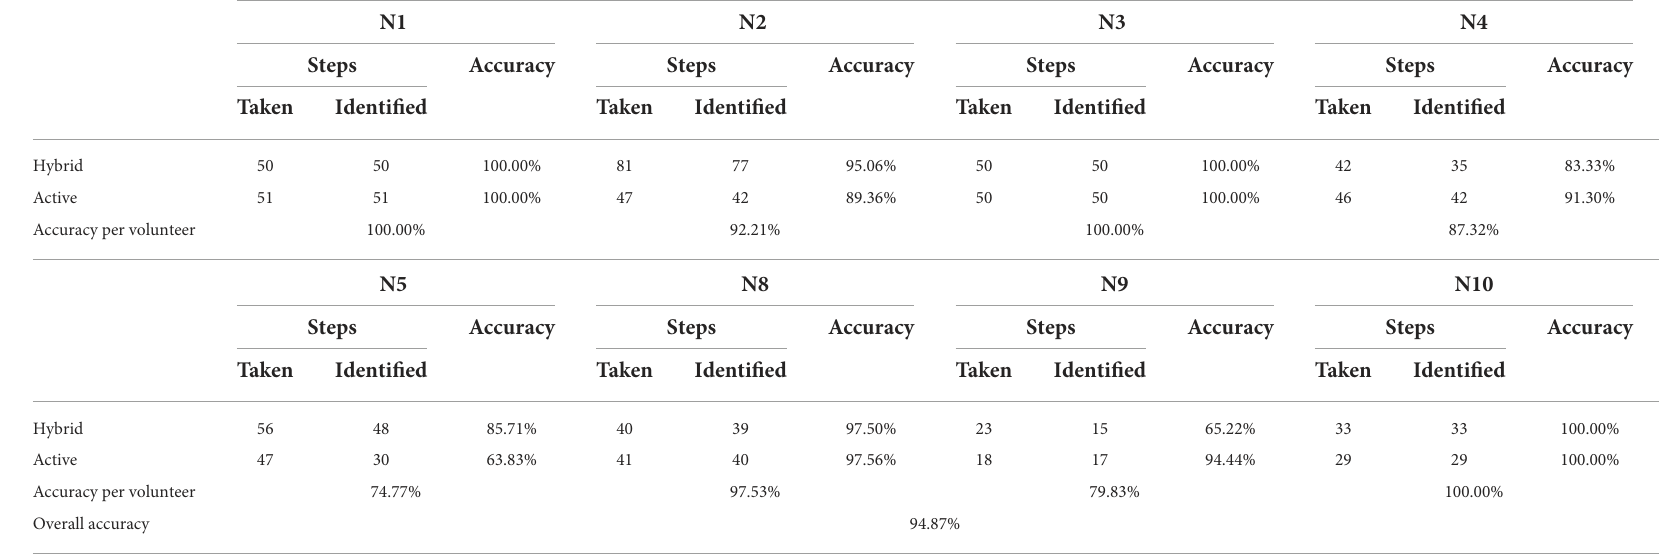
TABLE 2 Accuracy of G-Exos in identifying gait in volunteers with a foot